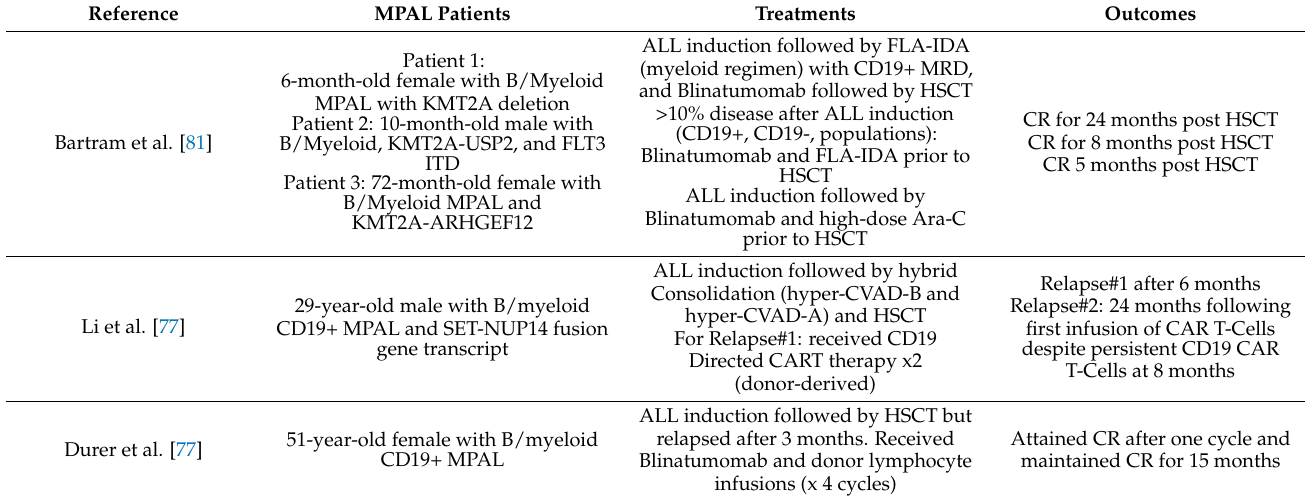
Table 3. Clinical reports utilizing immunotherapy to treat MPAL (FLA: fludrabine, cytarabine; IDA: idarubicin).